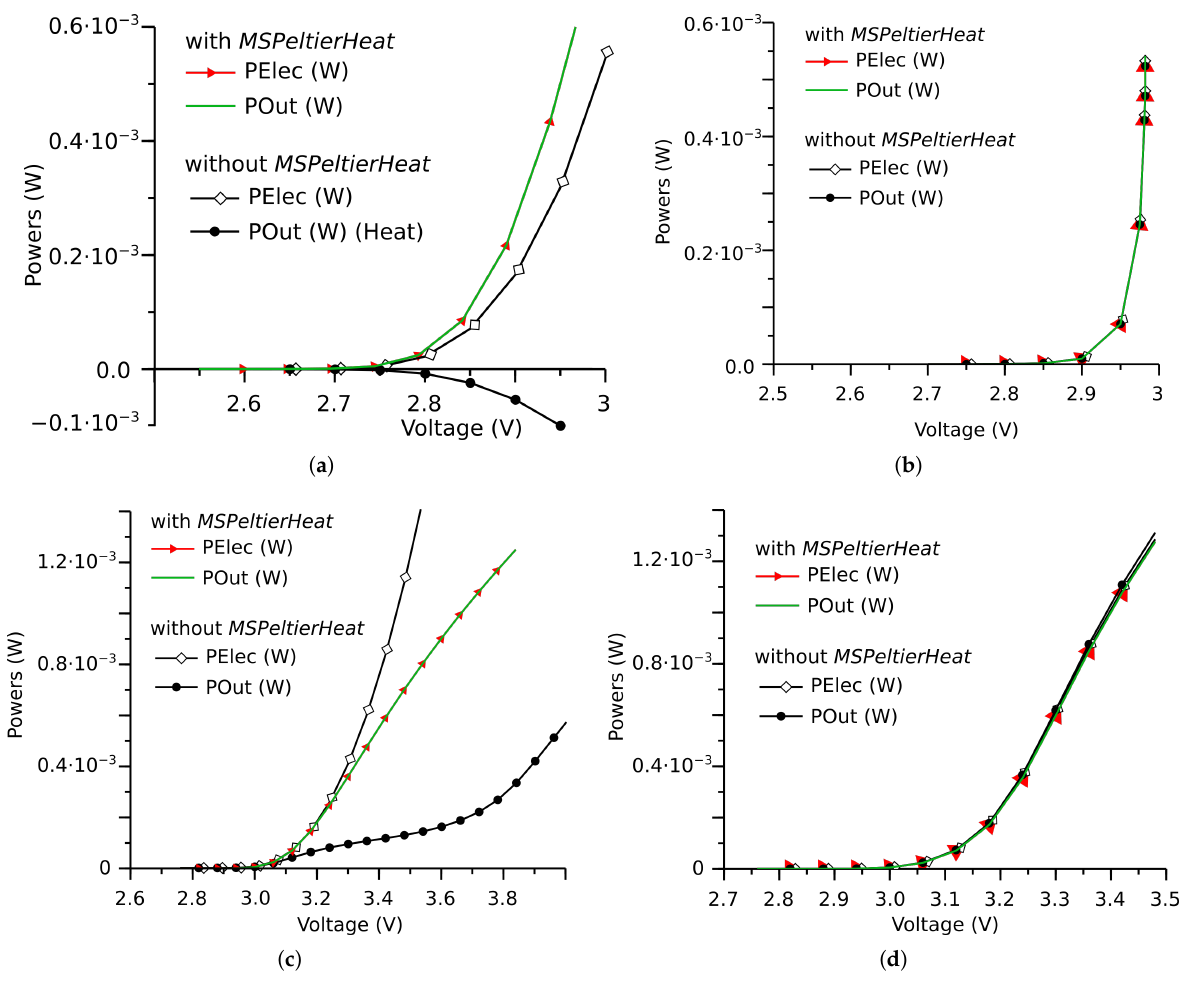
Figure 6. Input and output powers for SiC and GaN, structures S1 and S2, the structure parameters are: C = 0.5 µ m, = 10 21 cm − 3 , D = N + = 0.5 µ m, radiative recombination model is off. ( a ) SiC, S1; ( b ) SiC, S2; ( c ) GaN, S1; P + pd Dmax Amax ( d ) GaN,